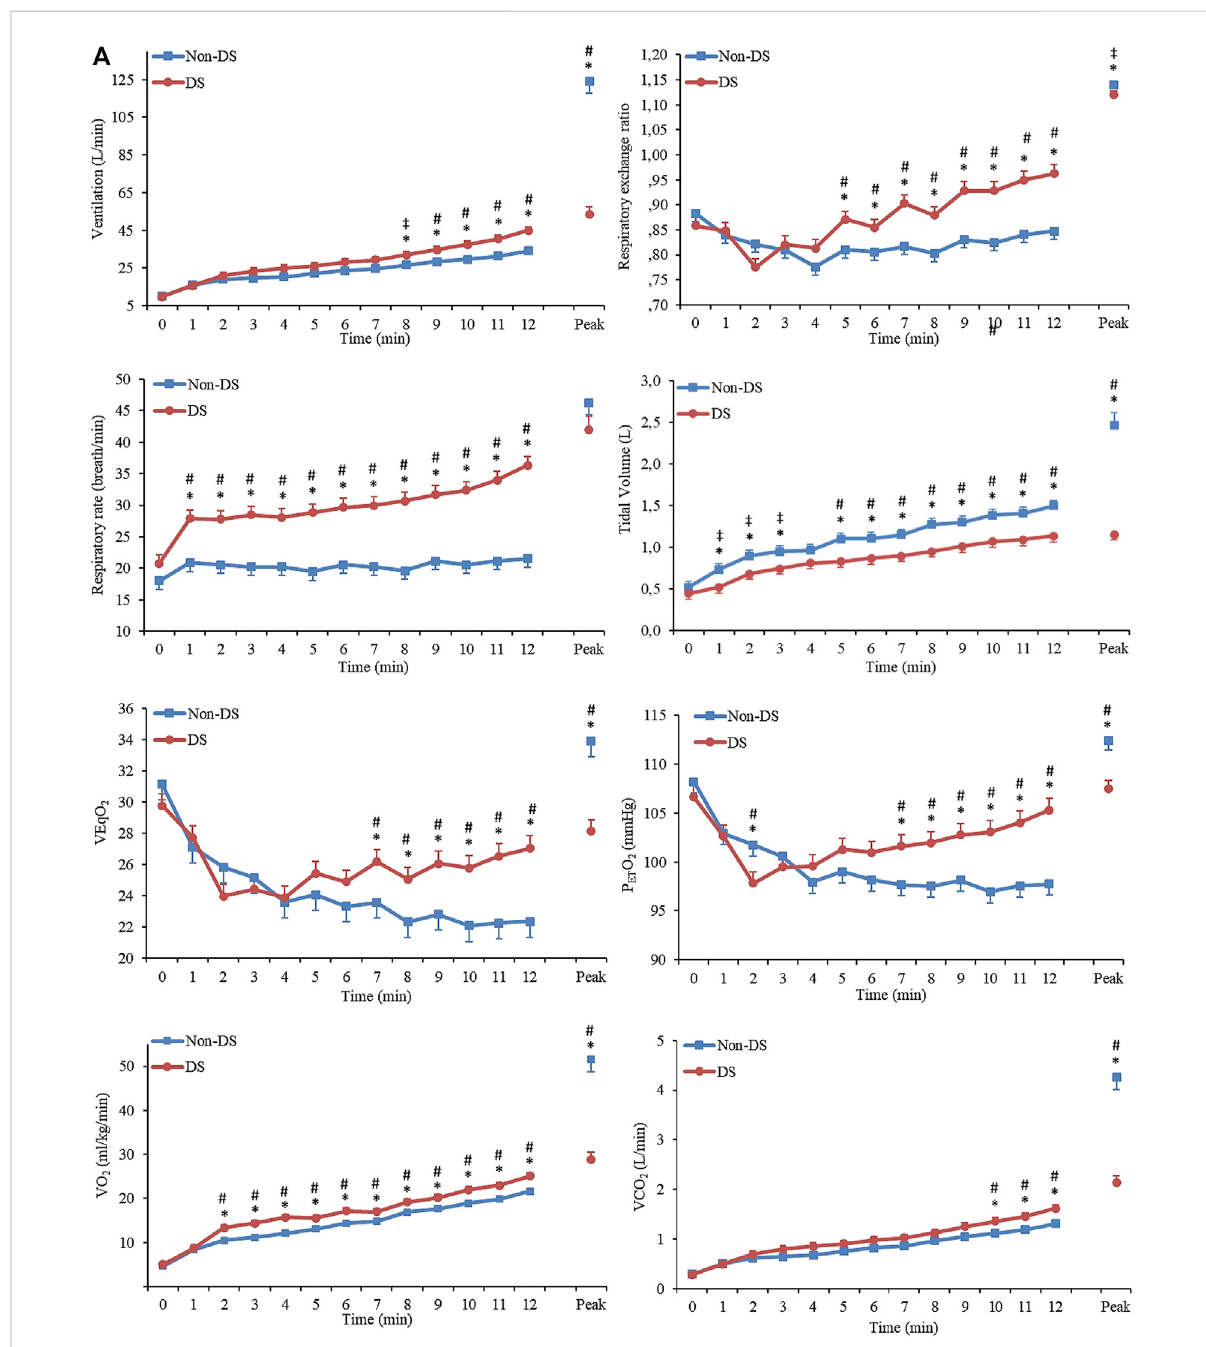
Cardiorespiratory and hemodynamic parameters in response to submaximal exercise in adults with and without Down syndrome. (A) : Cardiorespiratory parameters; (B) : Hemodynamic parameters. Abbreviations: DS (Down syndrome). Values are mean ± standard error. * Between- group differences ( p < 0.050). ‡ Medium effect size. # Large effect